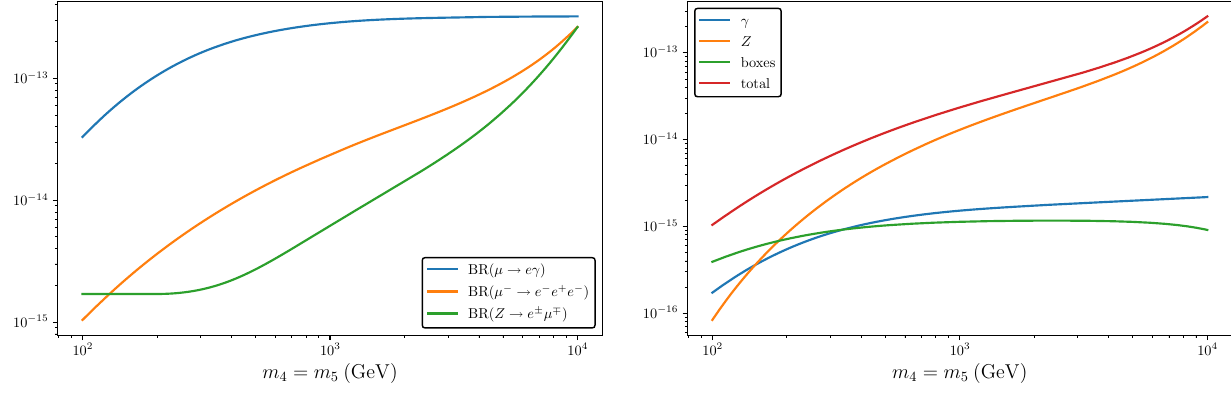
βα βα βα γ and G γ (blue), the Z -penguin form factor F Z